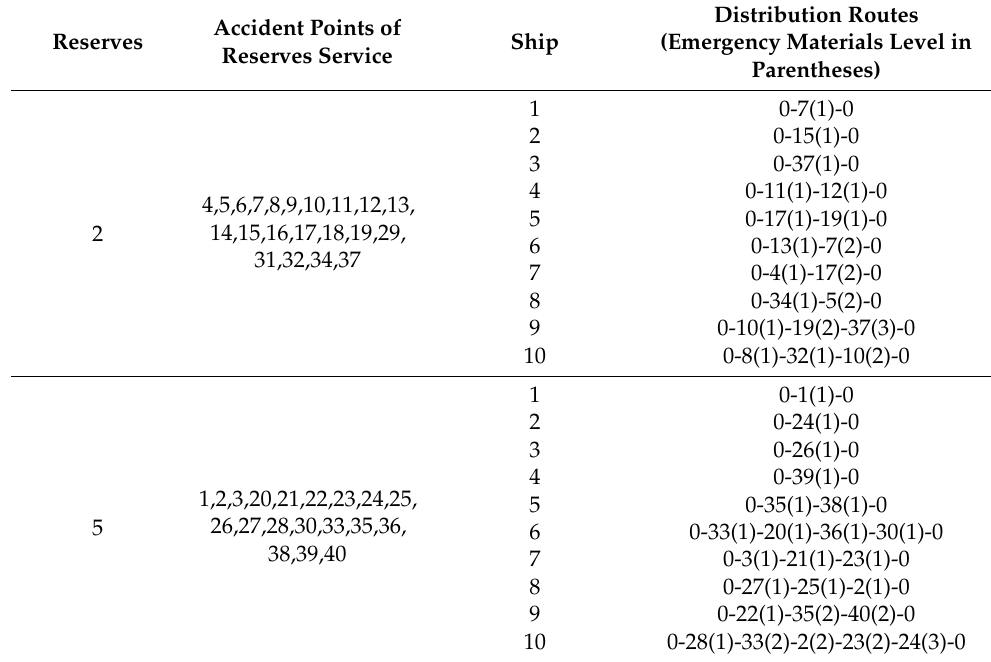
Table 8. Emergency materials distribution route table